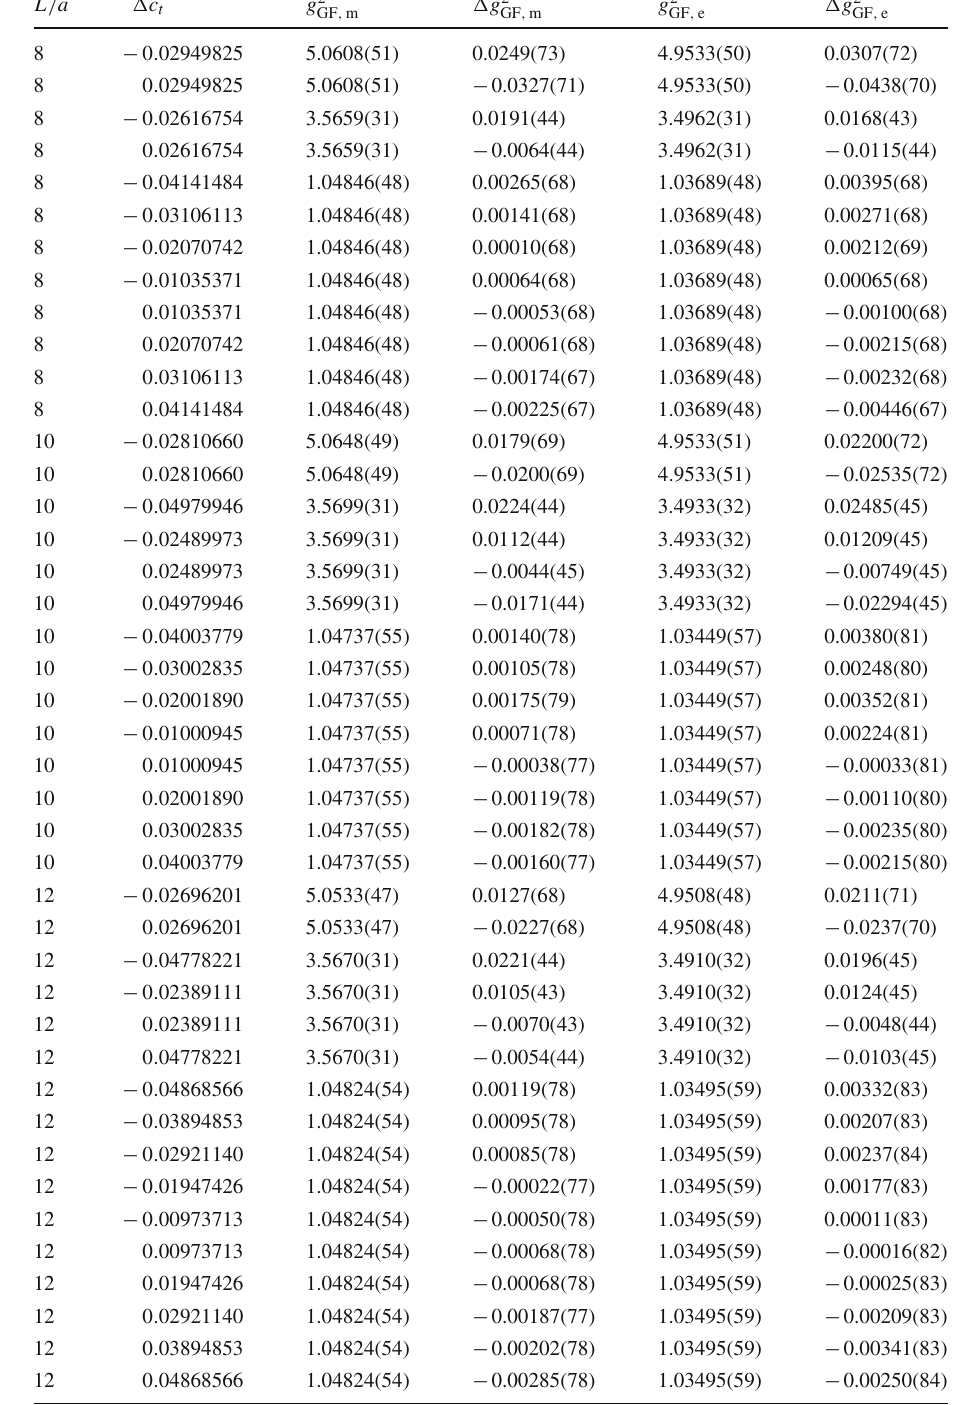
Table 7 Data to study the c t dependence of the GF couplings. The columns labelled by (cid:12) ¯ g 2 give the deviation GF , e / m of the GF couplings measured at c t = c (cid:20) t + (cid:12) c t , from the